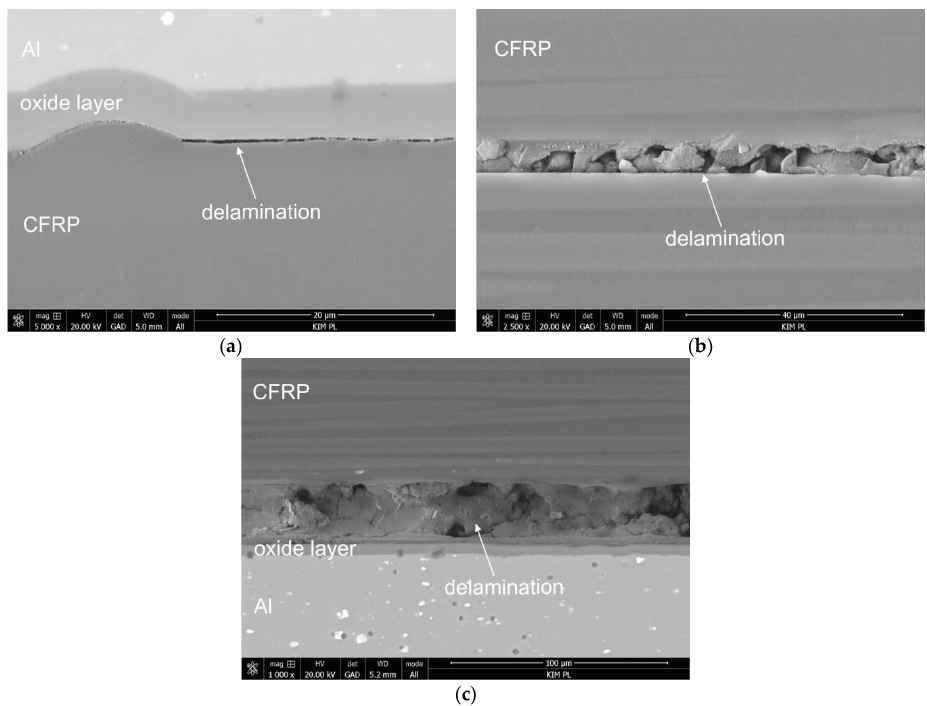
Figure 8. Types of damage in FML laminates without an additional glass composite layer (FML-C) before ( a ), ( b ) and after ( c ) hygrothermal conditioning.